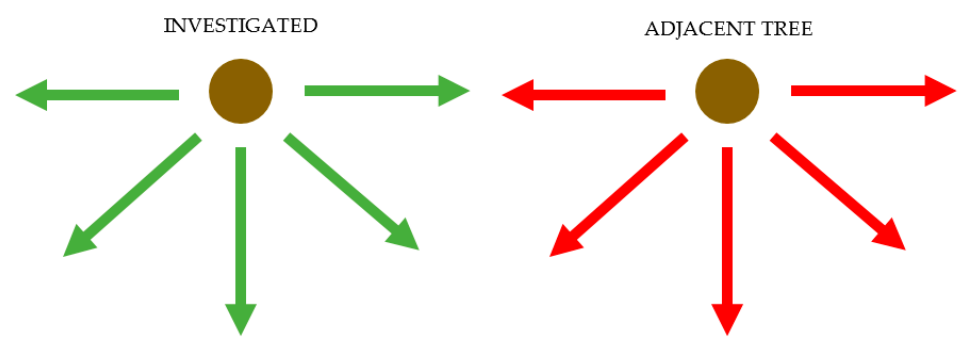
Figure 6. Layout of the roots’ main directions in the case of two adjacent trees. Directions of roots of a reference tree (e.g., the tree under investigation in this study) (in green ) are not compatible with the roots’ directions of a nearby adjacent tree (in red ).